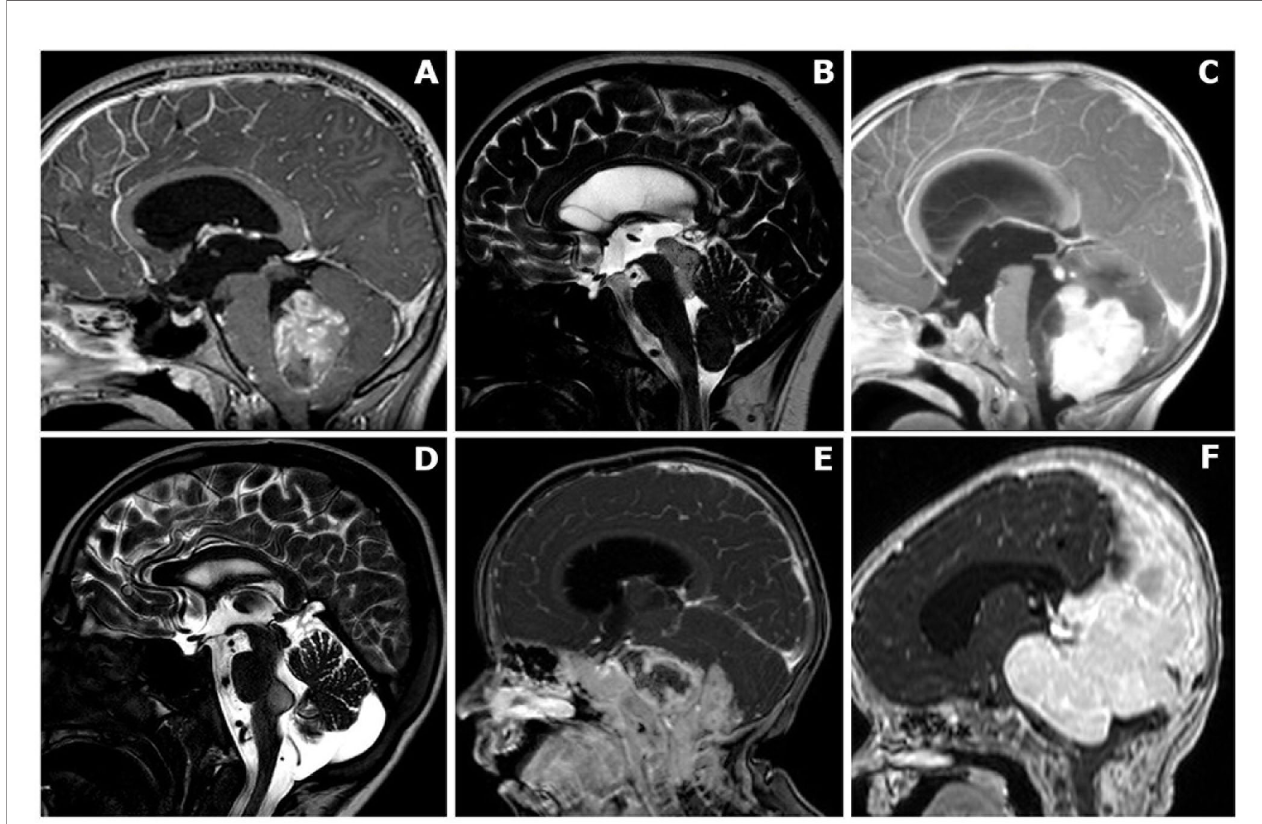
FIGURE 1 | Anatomical classi fi cation of posterior fossa tumors requiring surgical access to the fourth ventricle . (A) Mainly/purely intraventricular, without evident brainstem in fi ltration or extensive vermian in fi ltration. (B) Midbrain/intra-aqueductal tumor with signi fi cant bulging in the upper part of the fourth ventricle. (C) Cerebellar/vermian tumor with extensive parenchymal/vermian in fi ltration and secondary bulging into the fourth ventricle. (D) Cerebellopontine angle tumors extending into the fourth ventricle through the Luschka foramen/foramina. (E) Brainstem tumors with dorsally exophytic fourth ventricular component. (F) Giant tumors with extensive posterior fossa involvement, including a signi fi cant fourth ventricle